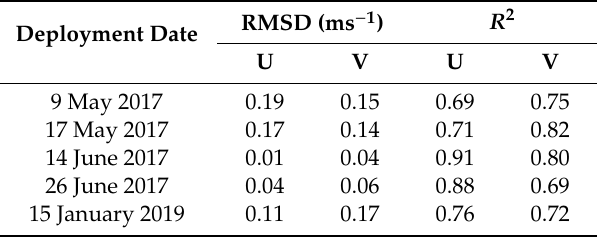
Figure 3. ( a ) The mean paths of drifters released in La Rochelle Bay and marina entrance; ( b ) and ( c ) The distance between observed and modelled drifter paths is displayed for every deployment; ( d ) Correlation of predicted-observed velocities (in ms − 1 ). Table 3. Statistical analysis between the observed and predicted circulation of drifters. RMSD and linear regression analysis R 2 were computed for zonal (U) and meridional (V) components of the velocity.